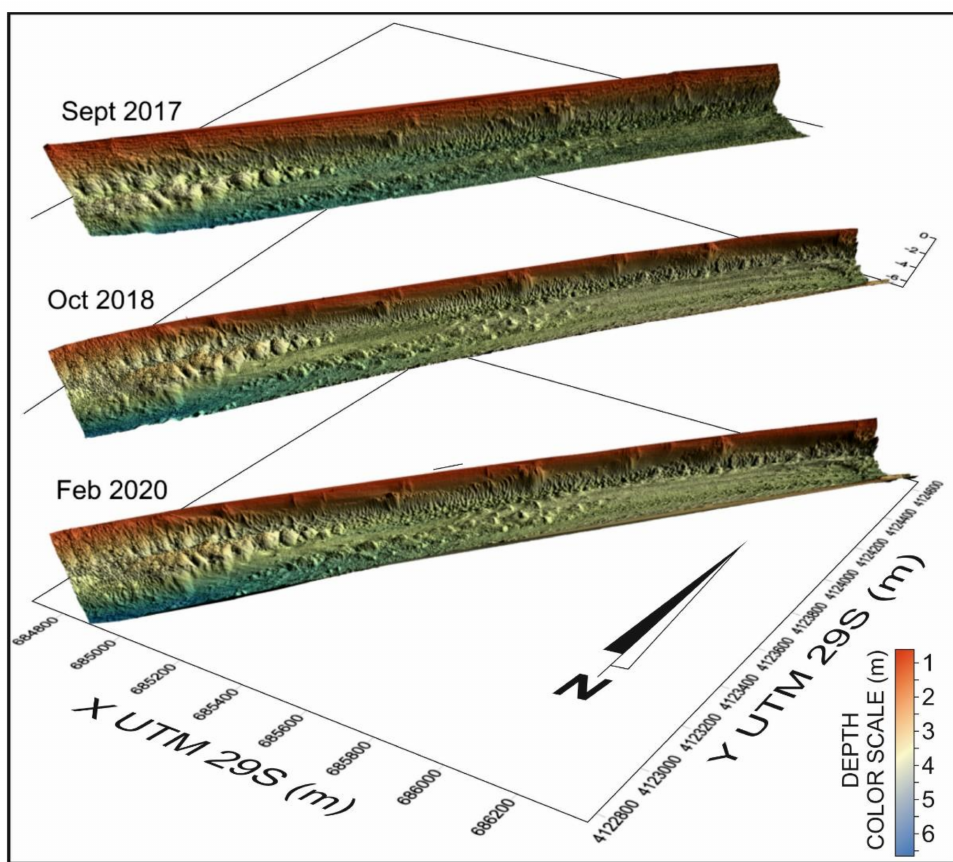
Figure 3. Comparison of the three multibeam bathymetric data represented as 3D block